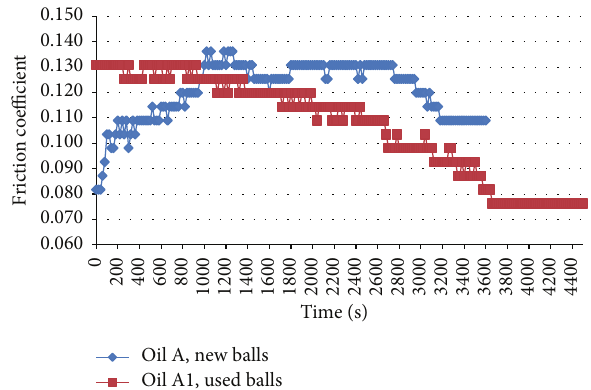
Figure 4: Friction coefficient variation with time using worn-out balls (tests 5a and 5b).